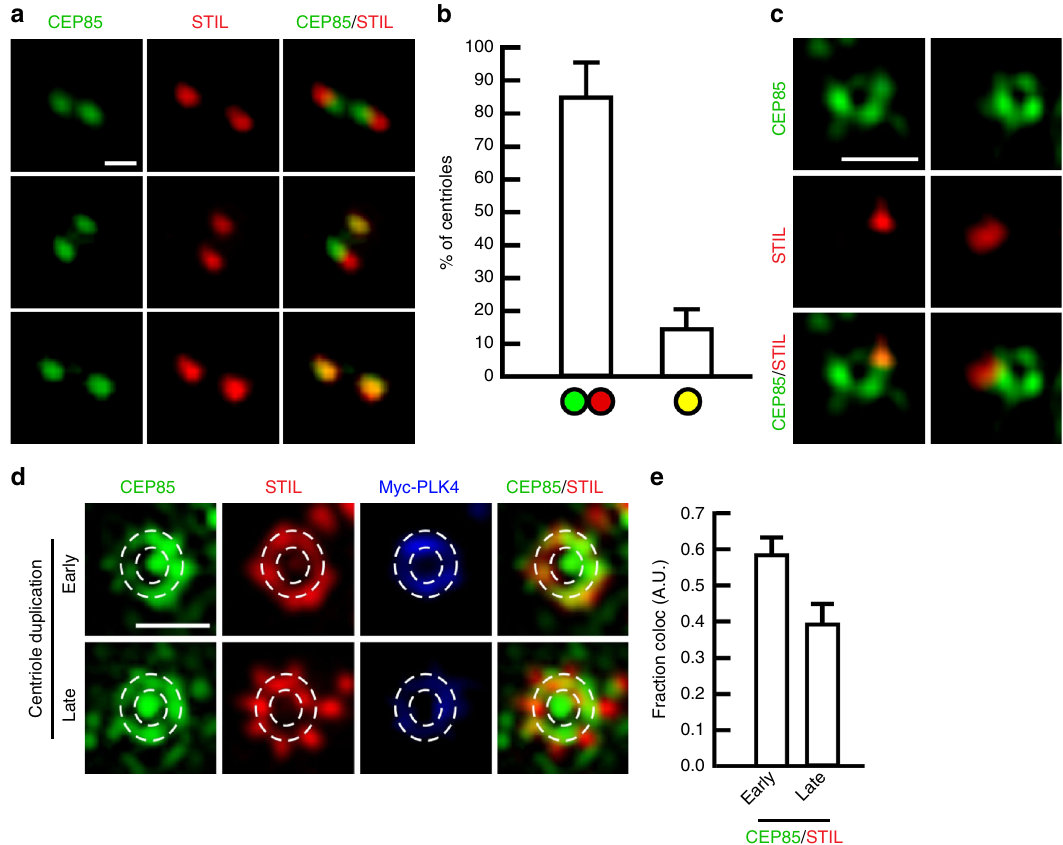
Fig. 3 CEP85 co-localizes with STIL at an early stage of centriole duplication. a , b IF analysis of CEP85 and STIL localization in U-2 OS cells after 24 h S- phase arrest using thymidine (1 mM). Selected images showing CEP85 and STIL labelling. b Bar graph, the percentage of centrioles with different localization patterns ( n = 100/experiment, three independent experiments). Scale bar 0.5 μ m. c 3D-SIM micrographs of S-phase arrested (1 mM thymidine) U-2 OS cells stained with the indicated antibodies. d , e 3D-SIM micrographs in U-2 OS Tet-inducible Myc-PLK4 cells after 24 h PLK4 induction and S-phase arrest using thymidine (1 mM), showing CEP85, STIL and Myc-PLK4 staining. PLK4 ring structures were encircled by white dashes. Scale bar 0.5 μ m. e The graph indicates the fraction co-localization between CEP85 and STIL ( n = 20/experiment, two independent experiments). All error